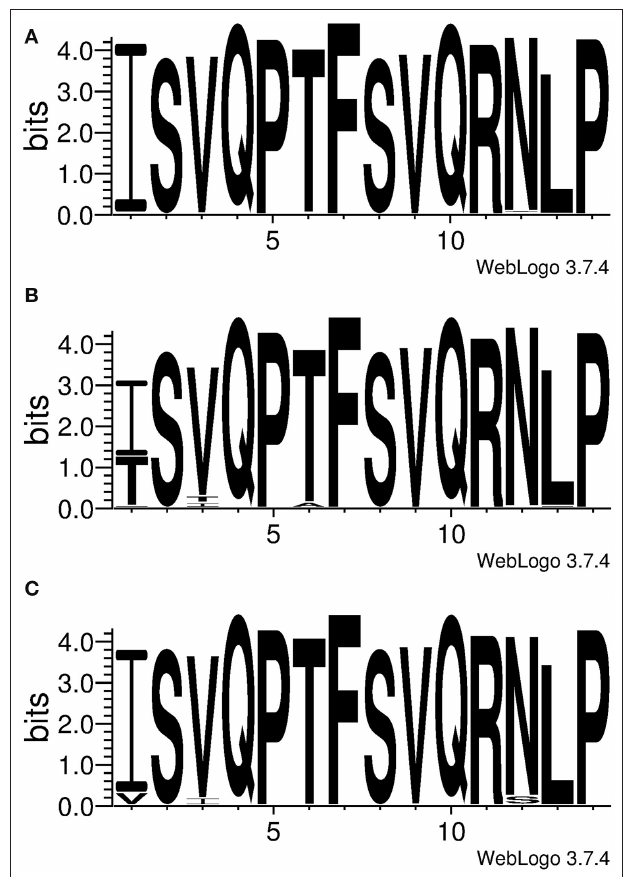
FIGURE 4 | Conservation of NP 406 − 419 , ISVQPTFSVQRNLP. The logo was generated using unique NP sequences of IAV isolated from (A) swine (B) human or (C) avian species. Letters represent the amino acid code and their height is proportional with the frequency.